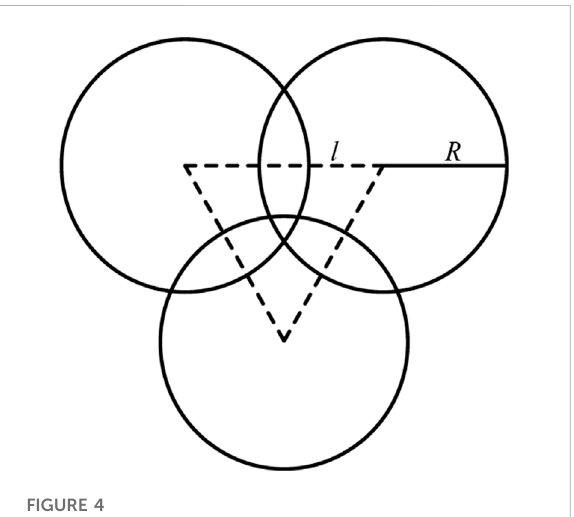
FIGURE 4 The plane arrangement of three circular